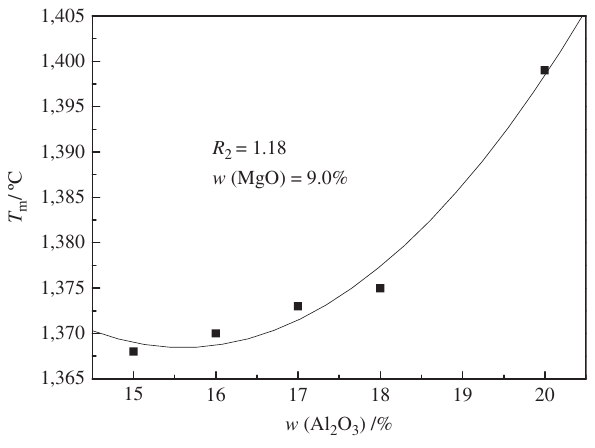
Figure 4: Effect of w (Al 2 O 3 ) on T m of slag.